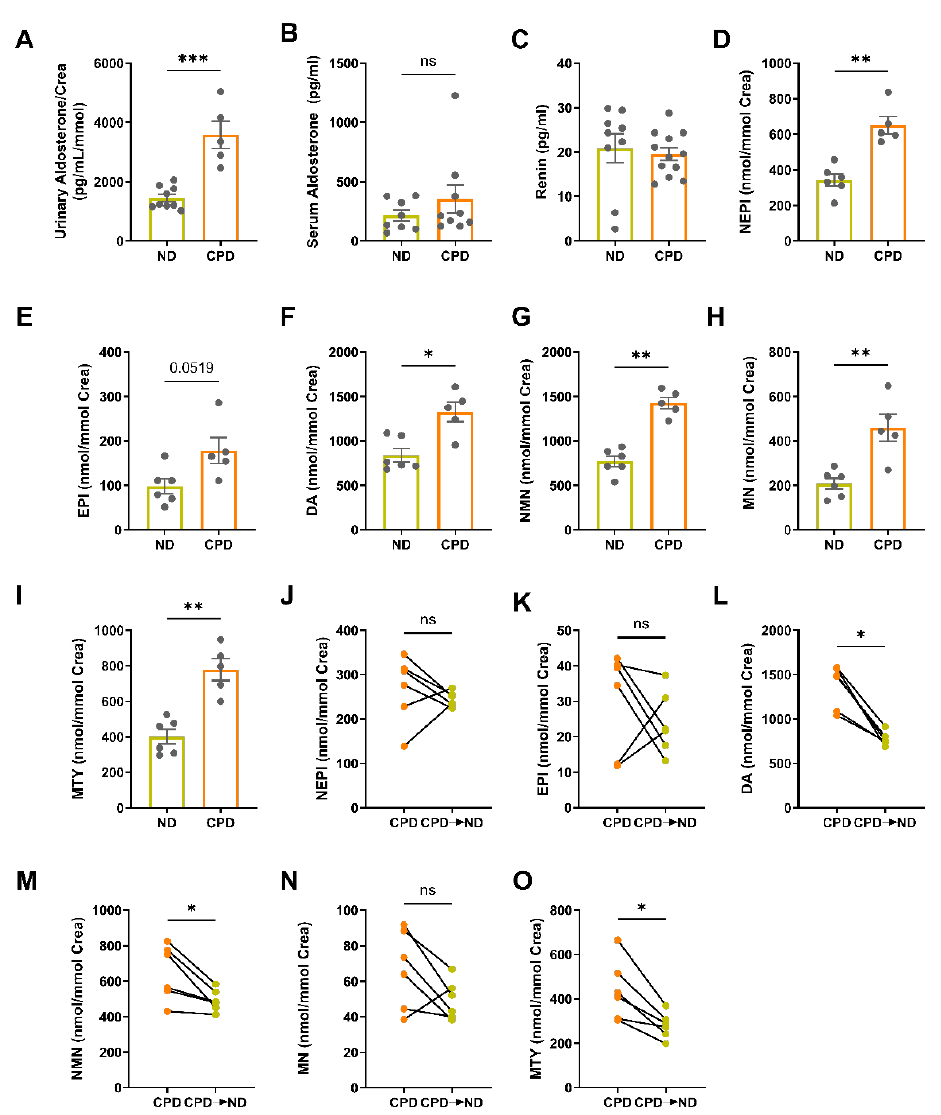
Figure 3. Chronically elevated dietary phosphate intake stimulates the renin–angiotensin–aldosterone system (RAAS) and increases sympathetic activity. ( A ) Urinary aldosterone secretion is increased in CPD mice ( n = 5–9). ( B ) Serum aldosterone and ( C ) serum renin concentrations are unchanged between mice fed CPD and ND ( n = 8–12). ( D – I ) Urinary excretion of the catecholamines norepinephrine (NEPI), dopamine (DA) and the catecholamine metabolites normetanephrine (NMN), metanephrine (MN) and methoxytyramine (MTY) are significantly elevated in mice fed the CPD compared to mice on ND, while epinephrine (EPI) did not reach statistical significance ( n = 5 – 6). Levels of ( J ) norepinephrine, ( K ) epinephrine and ( N ) metanephrine are not altered after switch- ing the mice from CPD to ND for two weeks. The diet switch lowered levels of ( L ) dopamine, ( M ) normetanephrine and ( O ) metoxytyramine ( n = 6). Bars in ( A – I ) represent mean ± SEM for ND and CPD mice. * p < 0.05, ** p < 0.01, *** p < 0.001 by Mann – Whitney U-test or Wilcoxon matched-pairs test. ns, not significant.